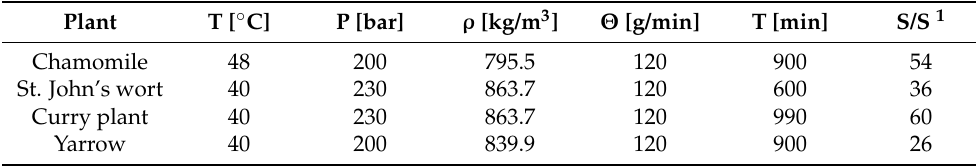
Table 5. The extraction parameters.